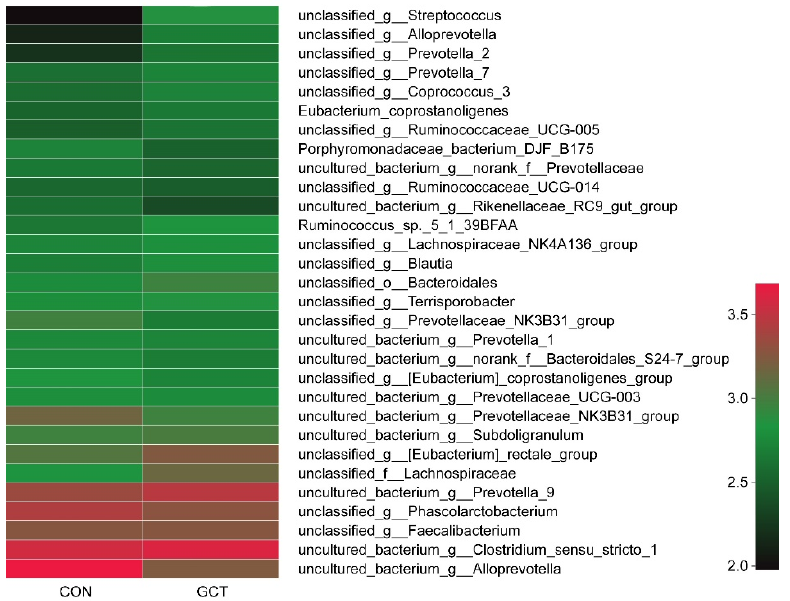
Figure 2. Heatmap shows the top 30 species of bacteria in the cecum of piglets. CON and GCT represent the control group and GCT-treated group, respectively. Numbers represent individual animals.